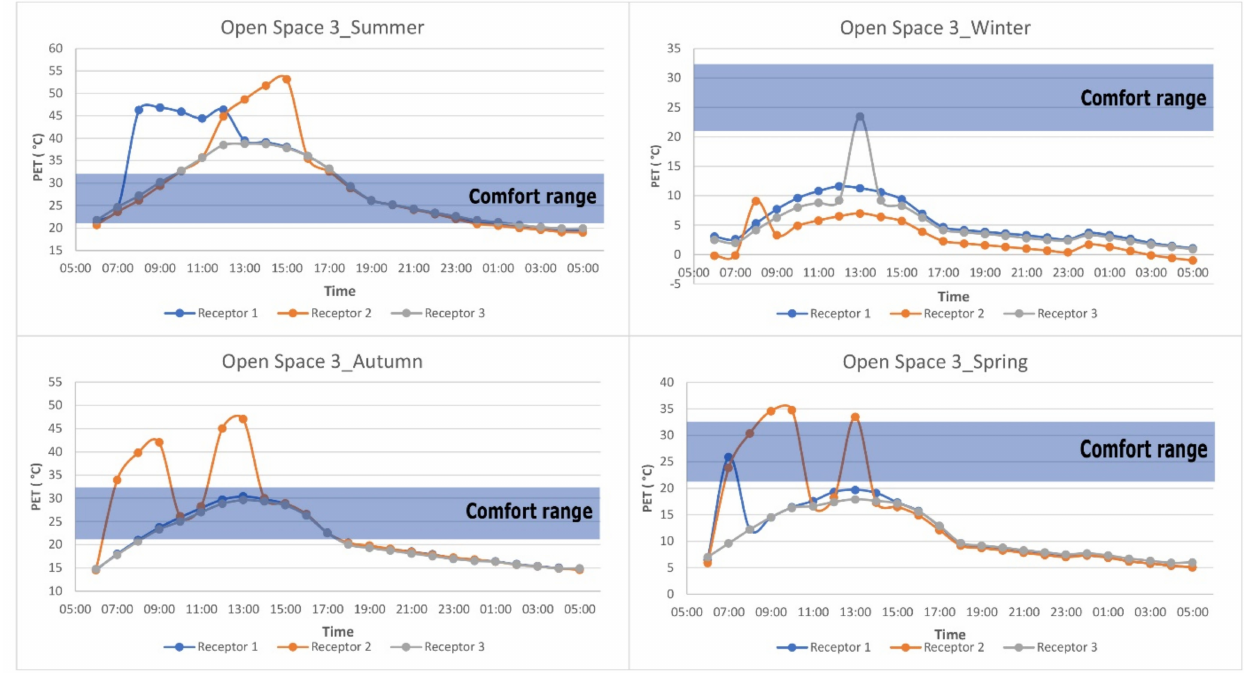
Figure 11. Open space 3 physiological equivalent temperature (PET) values throughout the